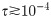
Microbial load.(A-B) The difference between models with finite (τ > 0) and infinite (τ = 0) host lifespan is shown, Eq (8). (A) For a slow occupation of empty space, the difference is maximal for small migration (m) and large τ as the model with τ = 0 predicts a distribution centred at frequency 1 decaying towards 0, whereas the model with τ > 0 predicts a distribution centred at frequency 0 decaying towards 1. For a fixed τ the difference is always greater for smaller m. Only for τ≳10-4 the difference is maximal and independent of m. Finally, a smaller τ always approximates the models; nonetheless within the range analysed the difference is always greater than zero. (B) A faster occupation of empty space decreases the difference and makes it increasingly independent of m, as τ dominates the predictions of the model. (C-D) The distributions are classified according to their number of maxima (unimodal or bimodal) and location (0 and 1). (C) A slow occupation of empty space results in microbe-free hosts being the maximum for short host lifespans (large τ), fully colonized hosts for large migration (m) and small τ, or microbe-free and microbe-occupied hosts simultaneously for small m and τ. The bimodality results from a limited migration preventing all the hosts from being colonized but over a host lifespan sufficient for successful colonizers to occupy host fully. (D) A faster occupation of empty space increases the bimodality region at the expense of the unimodal cases. In this case, α0 → −1 favours the microbe-occupied maximum. When classifying the distributions, any probability smaller than 10−9 was considered as zero. Other parameters: N = 104. We use Eq (5a) where no definition of pi and αi is required.